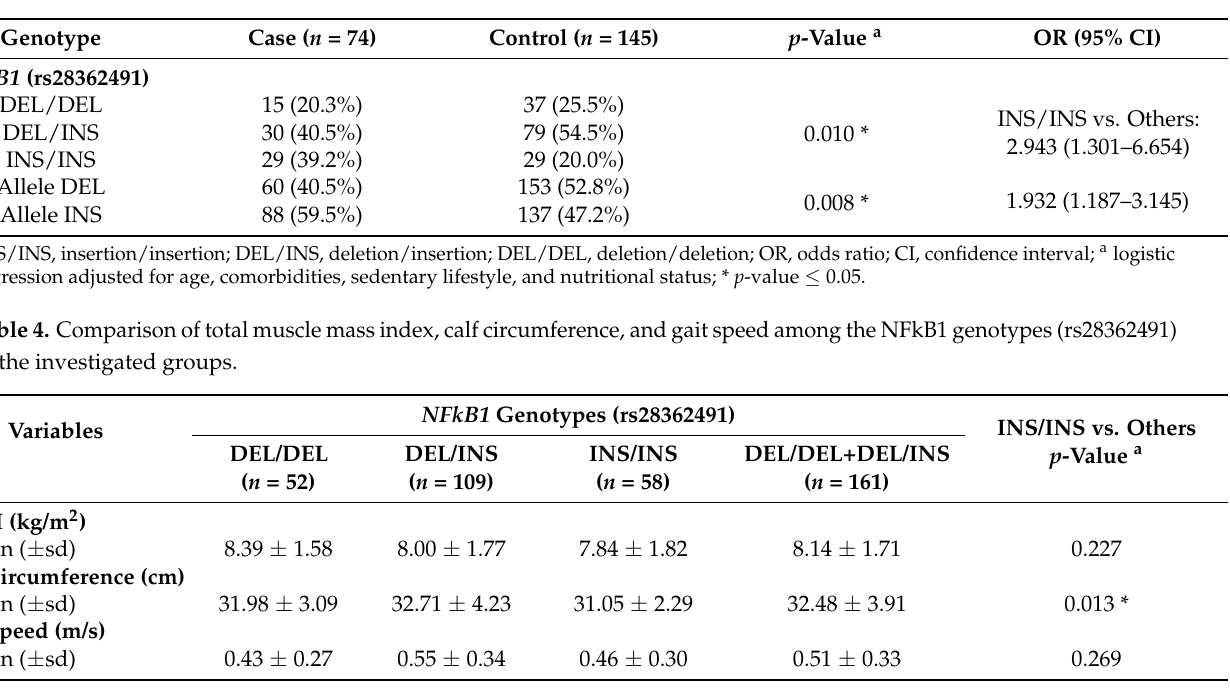
Table 3. Genotypic distribution of the NFkB1 gene polymorphism (rs28362491) in the investigated groups.